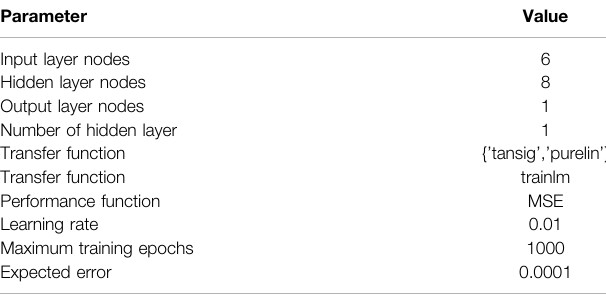
TABLE 1 | Parameter settings of ENN.